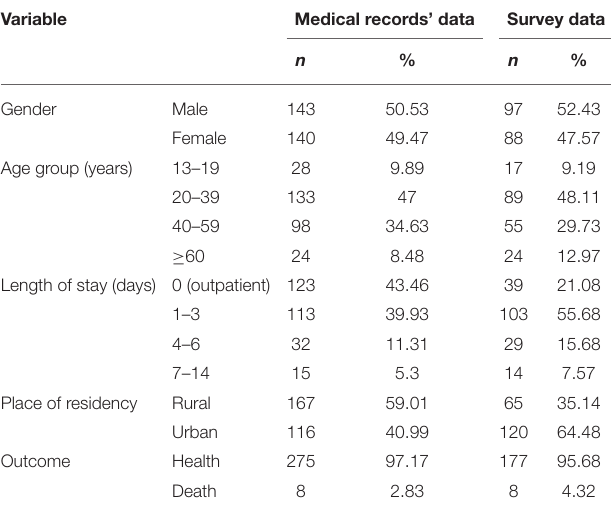
TABLE 1 | Characteristics of people who poisoned by cyclopeptide-containing mushrooms in Kermanshah province, Iran, 2018. Variable